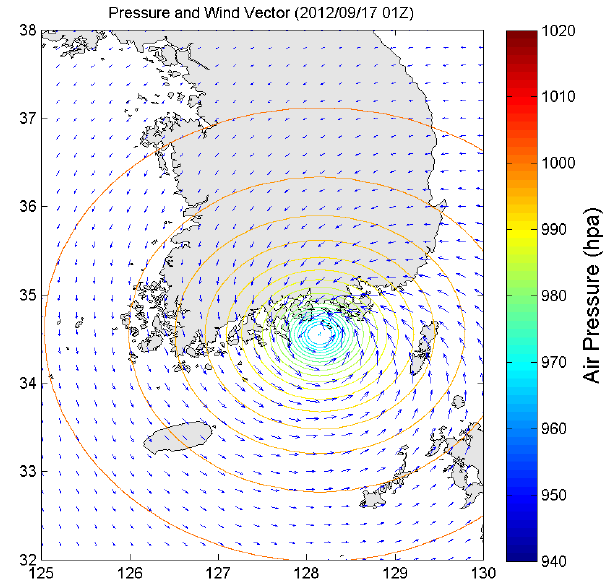
Figure 6. An example of a simulated typhoon wind field before